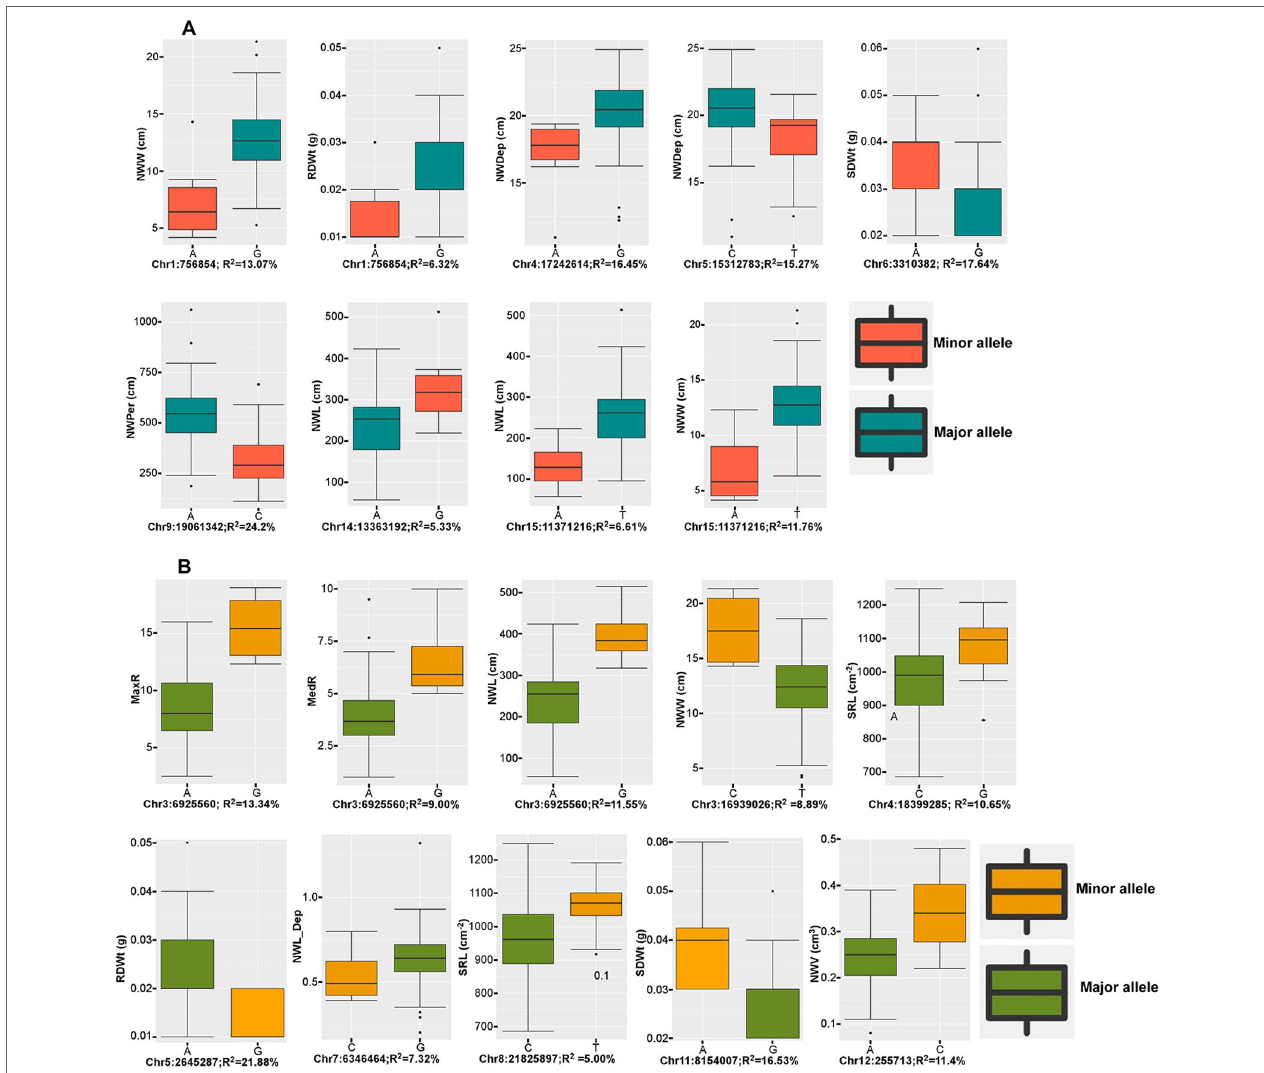
FIGURE 4 | Box plots of large effect quantitative trait nucleotides (QTNs). (A) Phenotypic variations at large effect QTNs consistently detected in both 3k and 7k datasets, and (B) phenotypic variation at large effect QTNs that were detected by at least two models in at one or both datasets. Trait abbreviations are listed in Table 1 .